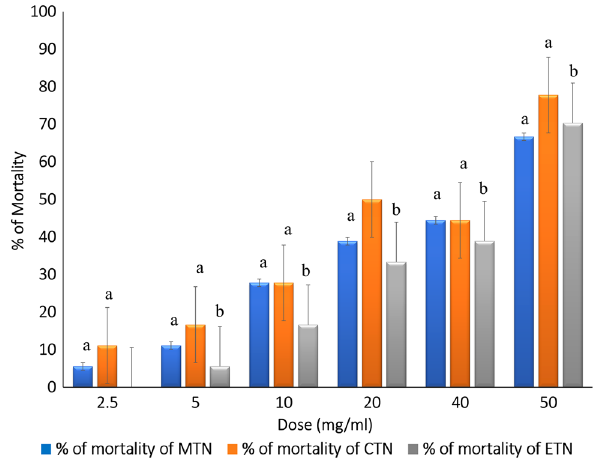
Figure 1: Insecticidal e ff ects of leaves of T. nudi fl ora. The values were presented as mean ± SEM. The outcomes were obtained using the Student ’ s t - test, where a and b were reported as p < 0.05, and p < 0.01 vs control,